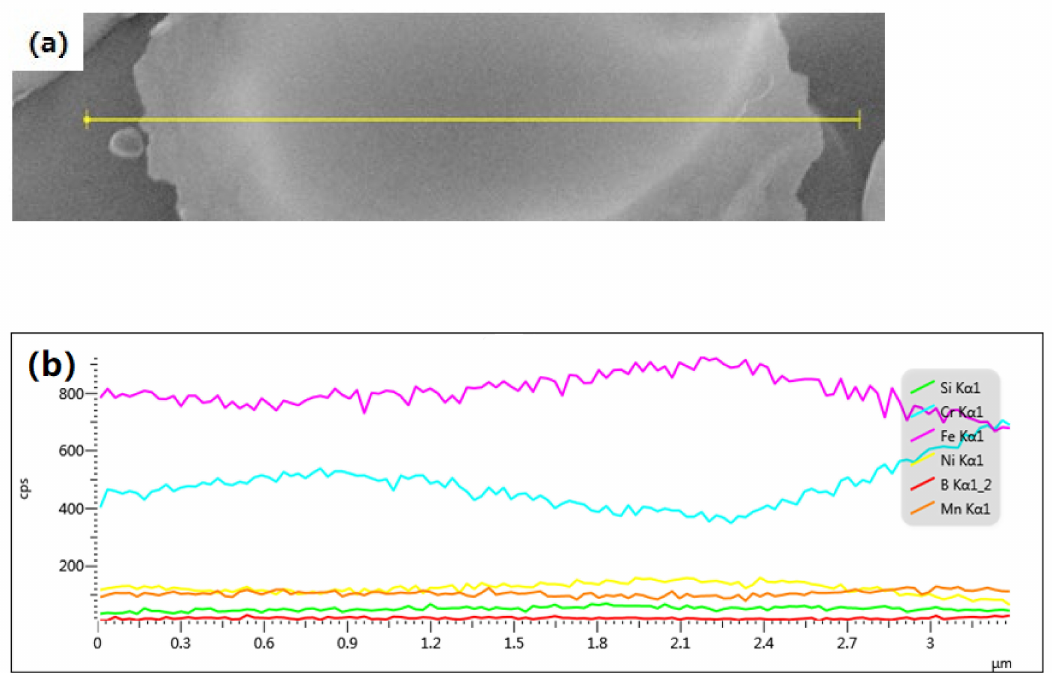
Figure 5. SEM-EDS line analysis of boron after heat treatment at 1100 ◦ C ( a ) line scan across grains; ( b ) curve of the relative content for different elements of the line